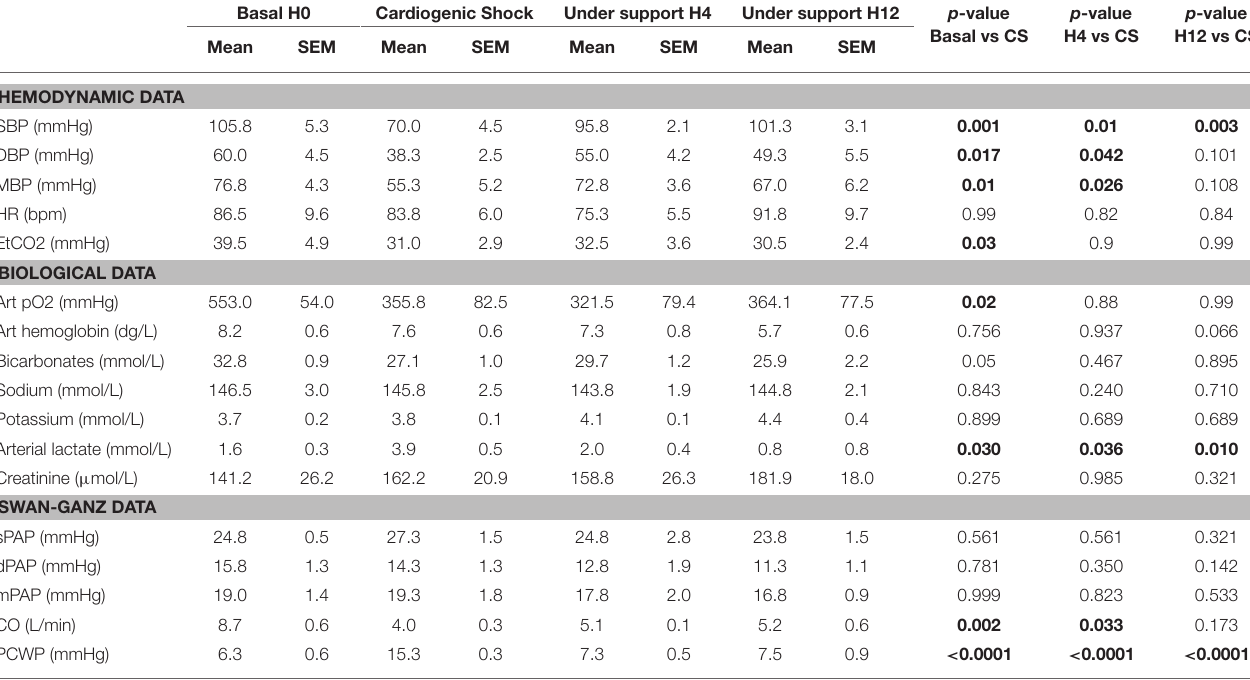
TABLE 1 | Comparative analysis of pigs’ characteristics before and during cardiogenic shock (CS) under IVAC2L support. Basal H0 Cardiogenic Shock Under support H4 Under support H12